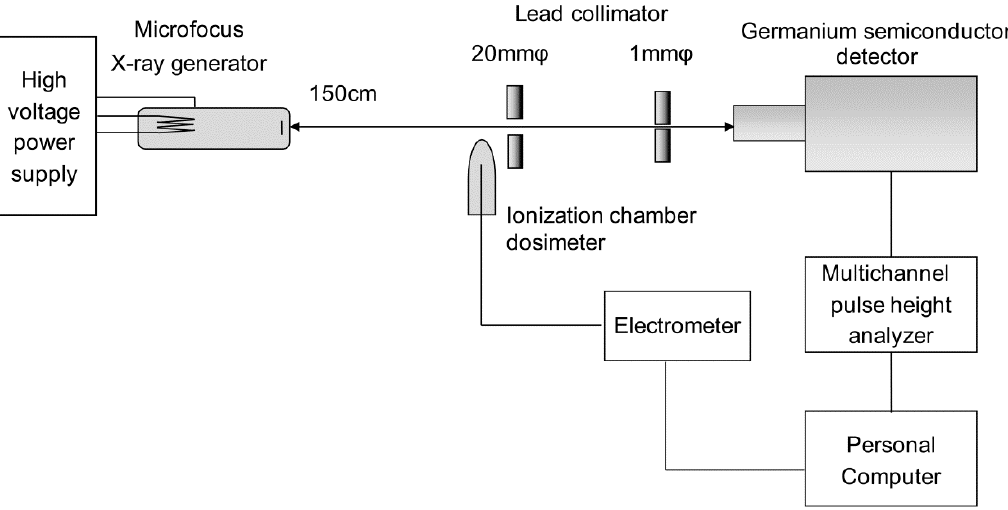
Figure 1. Geometric arrangement in X-ray spectrum measurement and measurement device block diagram.